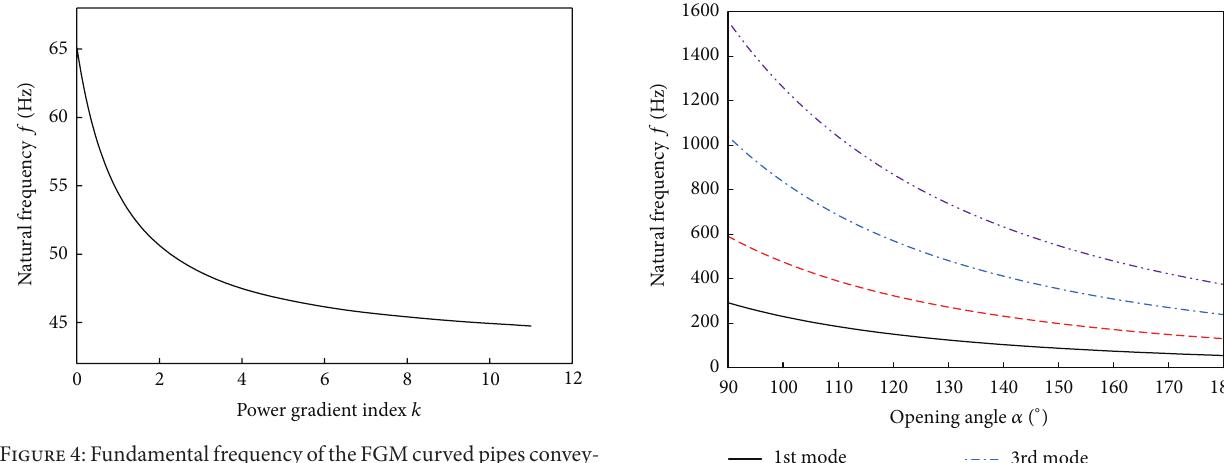
Figure 4: Fundamental frequency of the FGM curved pipes convey- ing fluid as a function of power gradient index for 𝑈 = 120 m/s.